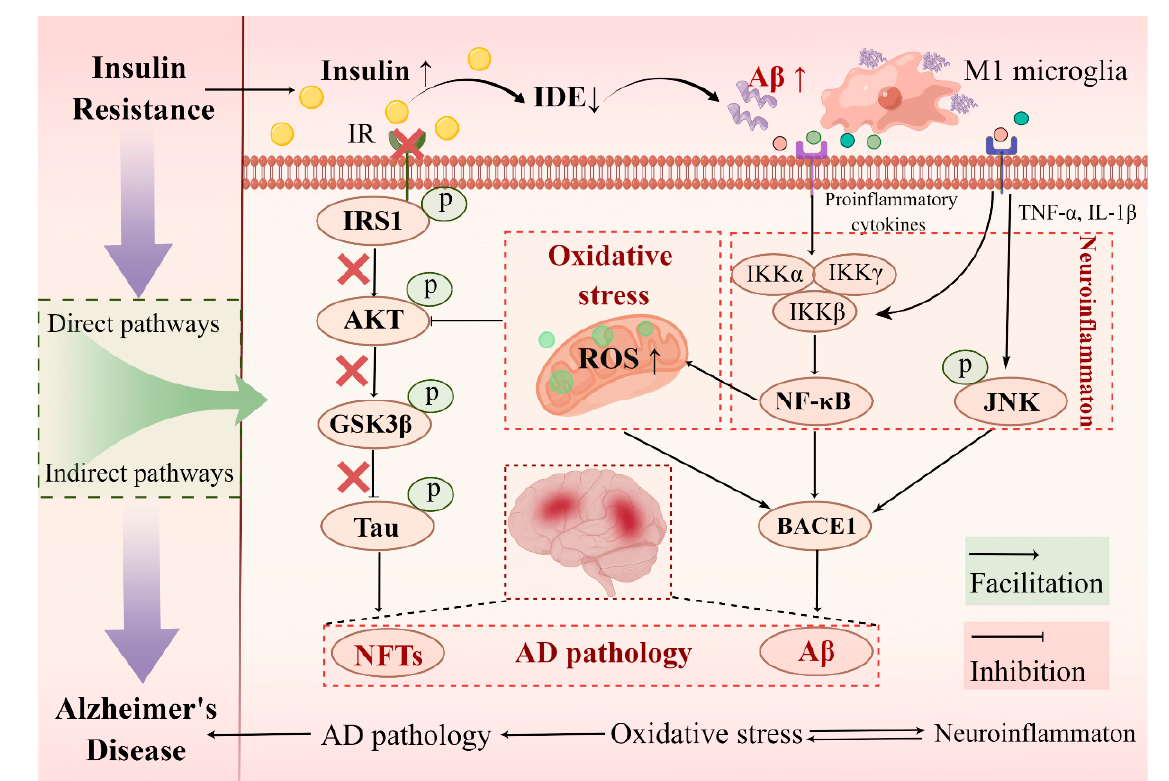
Figure 3. A molecular link between insulin resistance and AD. Insulin resistance contributes to the development of AD pathology through both direct and indirect pathways. Brain insulin resistance reduces IDE levels and insulin signaling directly induces A β deposition and tau hyperphosphorylation. In addition, insulin resistance-induced neuroinflammation and oxidative stress are also involved in the regulation of AD pathological progression. IR: insulin receptor, IDE: insulin-degrading enzyme, A β : amyloid beta, NFTs: neurofibrillary tangles, × : inhibiting effect (Drawn by